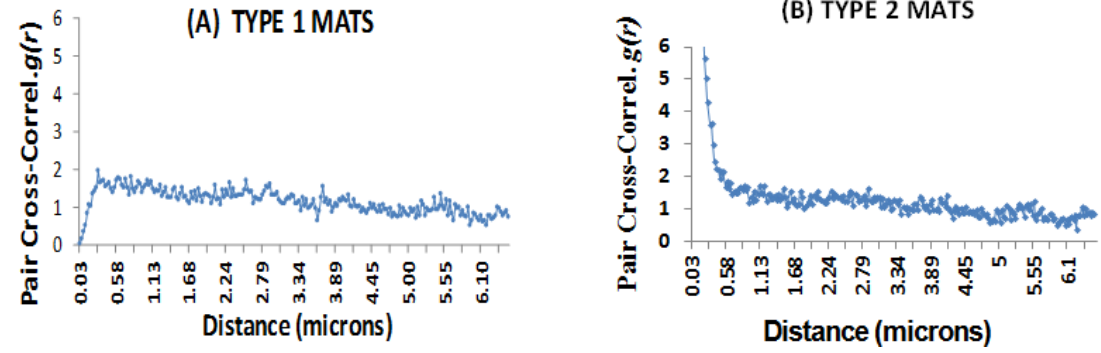
Figure 5. Microspatial clustering arrangements of SRM cells located in the surfaces of stromatolite mats using Daime analyses. The graphs exhibit the pair cross-correlation function g ( r ) for SRM cells. ( A ) In Type-1 mats, the relatively horizontal line where g ( r ) approximates 1 indicates relatively random SRM distributions over cell-cell distances ranging from 0.1 to 6.44 µm; ( B ) In Type-2 mats, values of g ( r ) above 1 indicate a high degree of clustering of SRM cells, especially over short (e.g., 0.03 to 0.36 µm) cell-to-cell distances. This indicates that cells in Type-2 mats are clustered closely